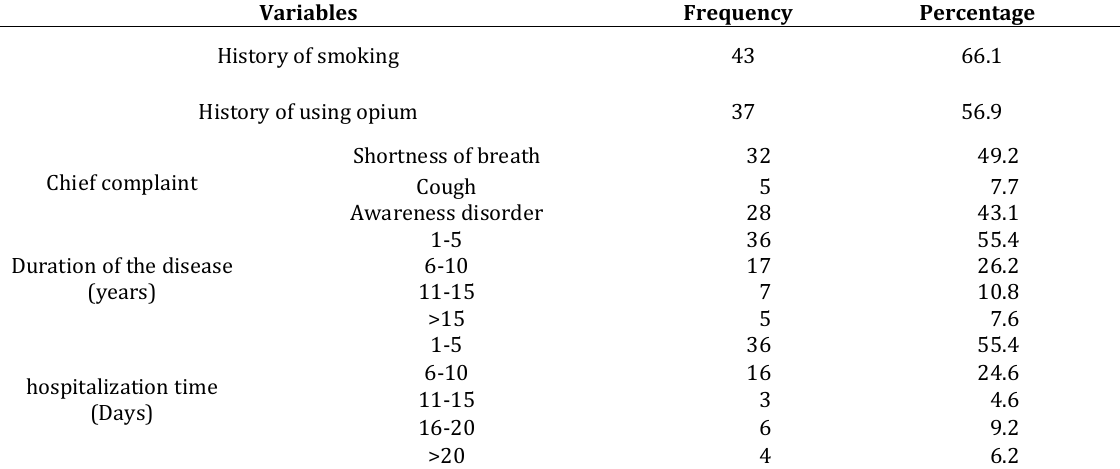
Table 1: Demographic variables